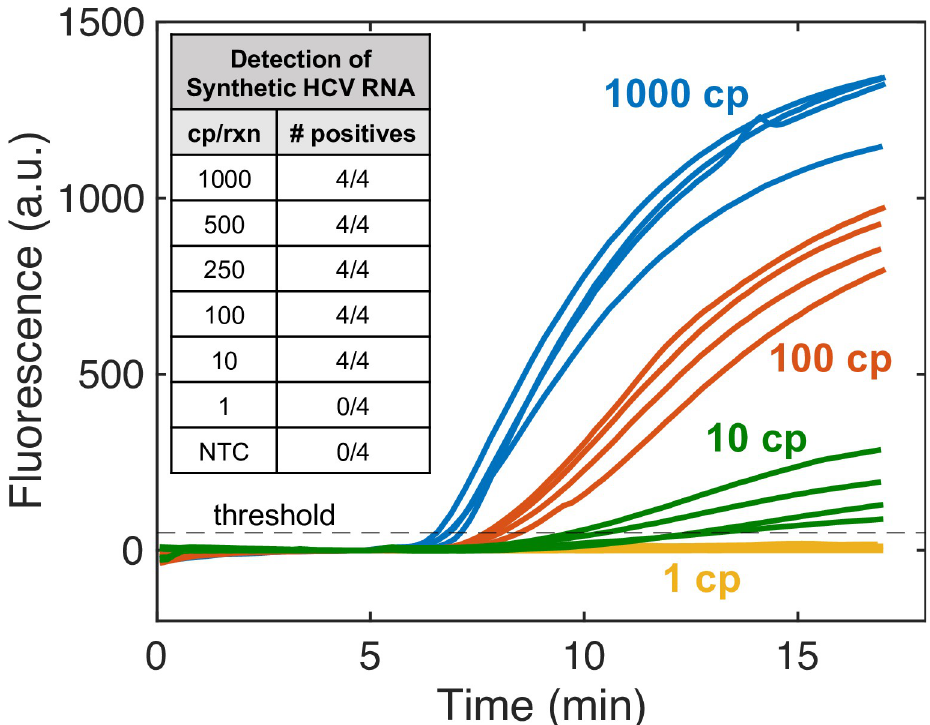
Fig 2. Detection limit of HCV RNA standards. The limit of detection of one-step RT-RPA was measured using HCV RNA synthetic standards. Real-time fluorescence measured from reaction tubes is plotted over 17-minutes for experimental data of 1000, 100, 10, and 1 copy per reaction. All reactions with input copies of RNA greater than or equal to 10 copies per reaction amplified in 15-minutes or less, while replicates with 1 copy per reaction and no template controls (NTCs) did not amplify. The inset table lists data for all input RNA concentrations tested. All concentrations were run with 4 replicates.